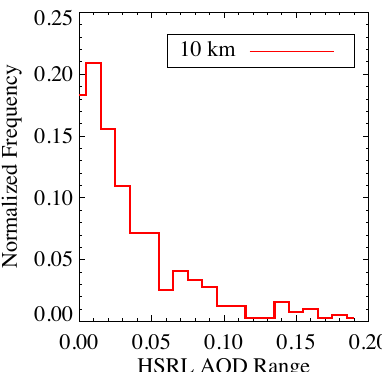
Fig. 5. The maximum difference between HSRL 0.55µm AOD measurements observed within a MODIS 10km pixel, normalized by the total number of analyzed grid boxes. Only MODIS pixels that contain 6 or more HSRL measurements are